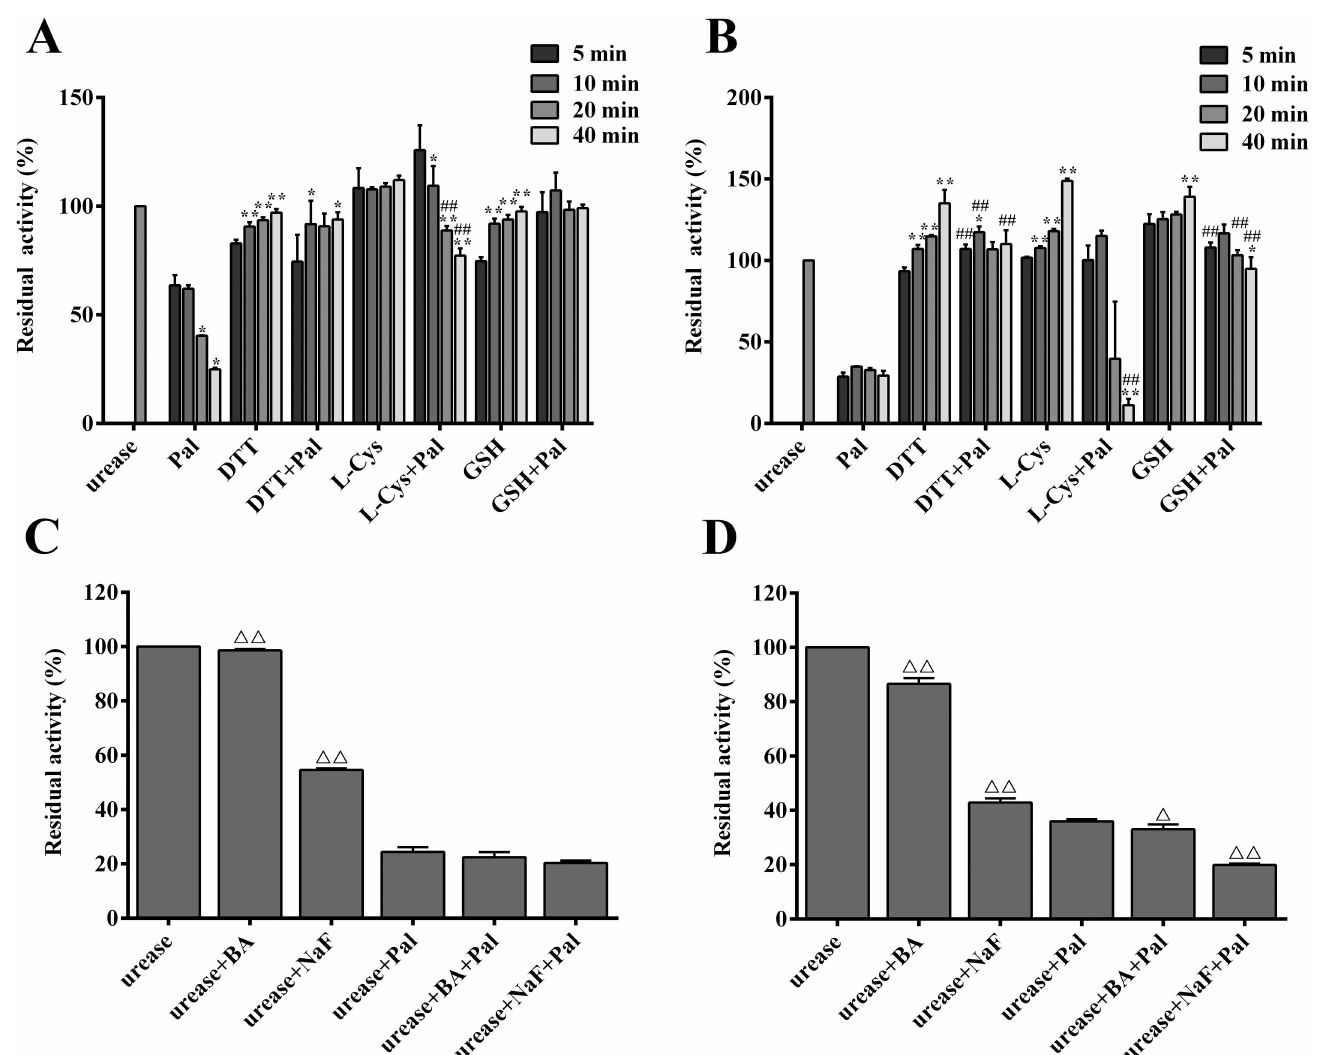
Fig 4. Effect of thiol-containing compounds and inorganic compounds on the inhibition of urease activity by Pal. Thiol reagentsprotected againstHPU ( A ) and JBU ( B ) inactivationby Pal. Inorganiccompoundsprotected againstHPU ( C ) and JBU ( D ) inhibitionby Pal. The concentrations of both ureases were 0.25 mg/mL. Concentrations of all thiol-containing compounds were 1.25 mM and the competitiveinhibitors were 5 mM. The concentration of Pal was 0.5 mM for both HPU and JBU in the assays. After 5, 10, 20, and 40 min of incubation, residualurease activity was assayed respectively. Residualactivity values were expressed as percent of the control activity. The residualactivity of ureasein the presenceof Pal without the protector or urease in the presenceof protector without the Pal was given for comparison. Results presented here are the mean value of n = 3 ± SD. * P < 0.05 and ** P < 0.01 were consideredas significantdifferenceswhen comparedwith control (the first column of each group), ## P < 0.01 in comparisonto the control (urease in the presenceof protector without the Pal group), and Δ P < 0.05 and ΔΔ P < 0.01 in comparisonto the control (urease in the presenceof Pal without the protector), as determined by